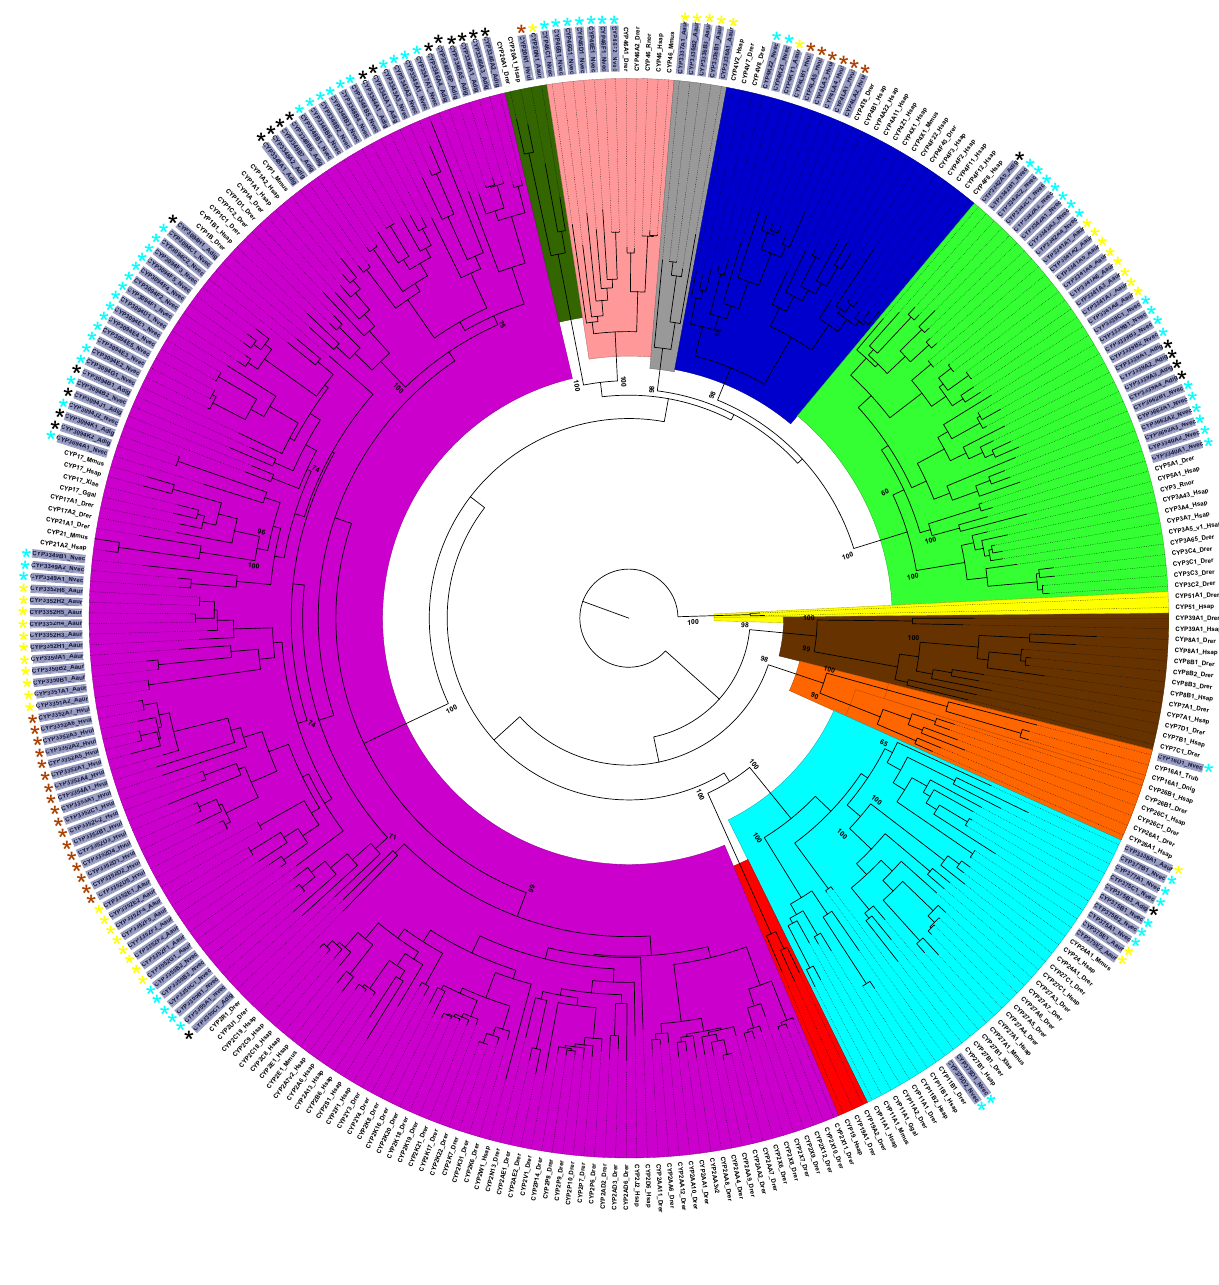
Figure 2. Maximum likelihood phylogenetic tree of cnidarian cytochrome P450 enzymes. The tree was generated with rapid bootstrapping and a gamma distribution with the JTT substitution matrix. Each CYP clan was assigned a different colour on the tree branches: clan 2 is purple, clan 3 is light green, clan 4 is blue, clan 7 is brown, clan 19 is red, clan 20 is dark green, clan 26 is orange, clan 46 is salmon, clan 51 is yellow, mitochondrial clan is turquoise. The five A. aurita CYPs that do not fit into established metazoan clans are light grey. The cnidarian CYPs are highlighted in dark grey on the perimeter of the tree. The different coloured asterisks indicate which cnidarian each CYP is from: H. vulgaris is brown, A. digitifera is black, A. aurita is yellow, N. vectensis is turquoise. The tree is rooted with the CYP51 family. Bootstrap values for each CYP clan, major CYP family divisions within each clan and major cnidarian clades are indicated on the tree. Bootstrap support for the placement of the branches that separate the individual clans was low (less than 50). Species acronyms are based on the family and species: Drer—zebrafish, Ggal—chicken, Hsap—human, Mmus—mouse, Rnor- rat, Xlae— frog, Trub—fugu pufferfish, Dnig—green pufferfish, Hvul—brown hydra, Adig—stony coral, Aaur—moon jellyfish, Nvec—starlet sea